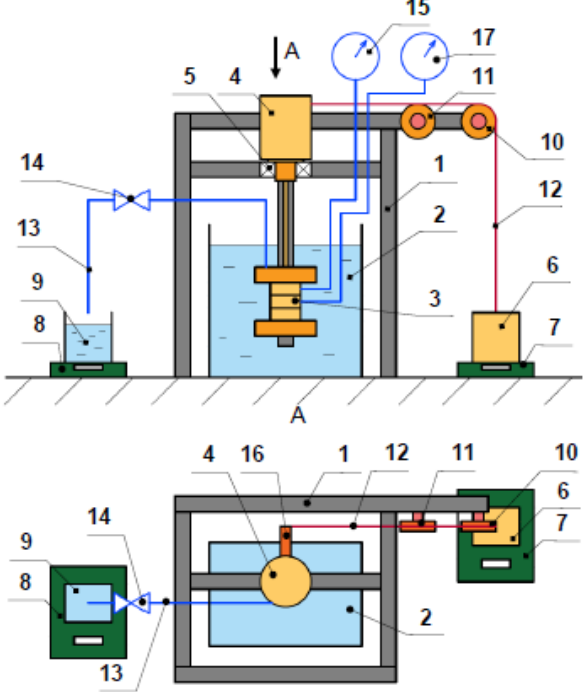
Figure 2. Diagram of laboratory test bench for pump micromodels: 1, frame; 2, tank with working fluid; 3, the test sample; 4, adjustable electric drive; 5, pivoting bearing; 6, load; 7, 8, scales; 9, measuring container; 10, 11, block; 12, cable; 13, delivery line; 14, adjusting valve; 15, 17, pressure gauge; 16, lever.